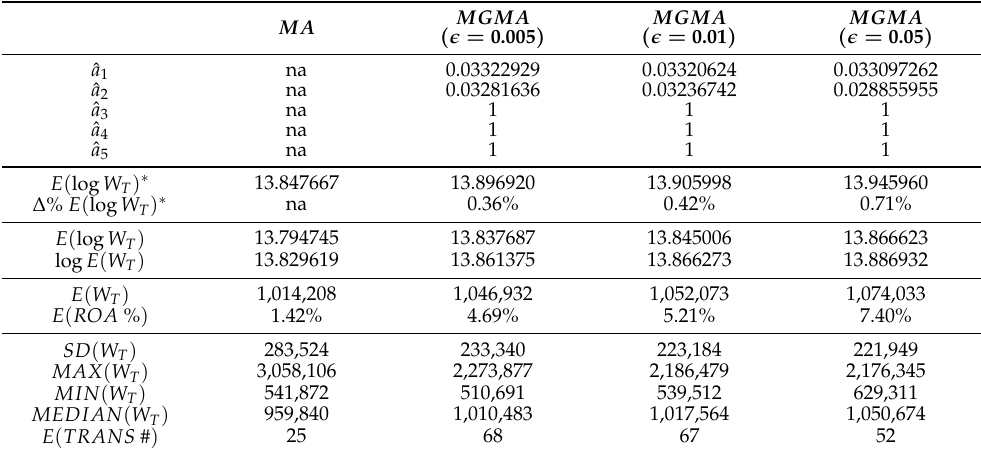
Table 4. MGMA strategy performance summary for scenario 1 on the simulated two-asset portfolio (1000 run; s = 5; l =